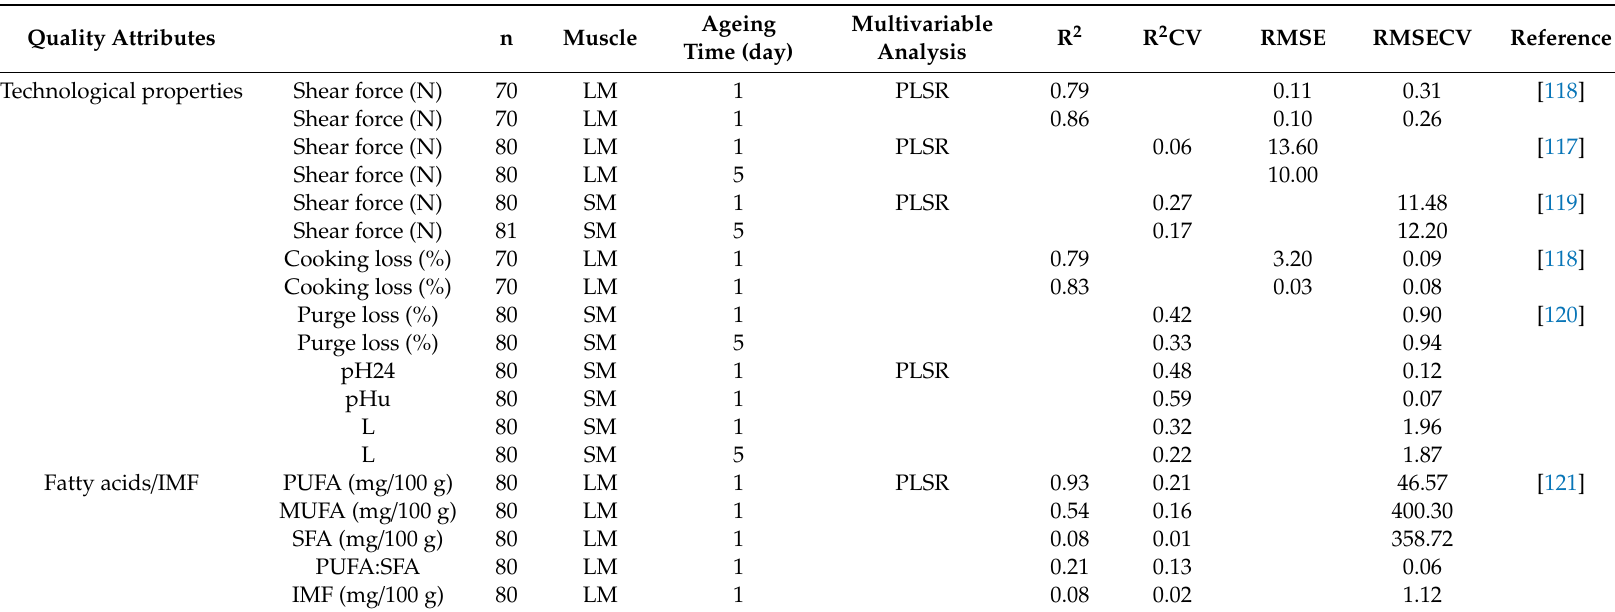
Table 7. Summary of Raman spectroscopy studies for evaluating quality attributes of lamb